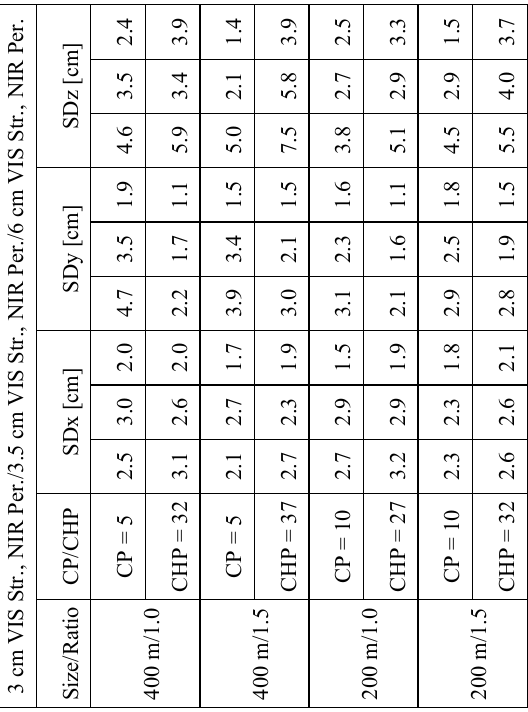
Table 7. Standard deviations of control points and check points measured by terrestrial method